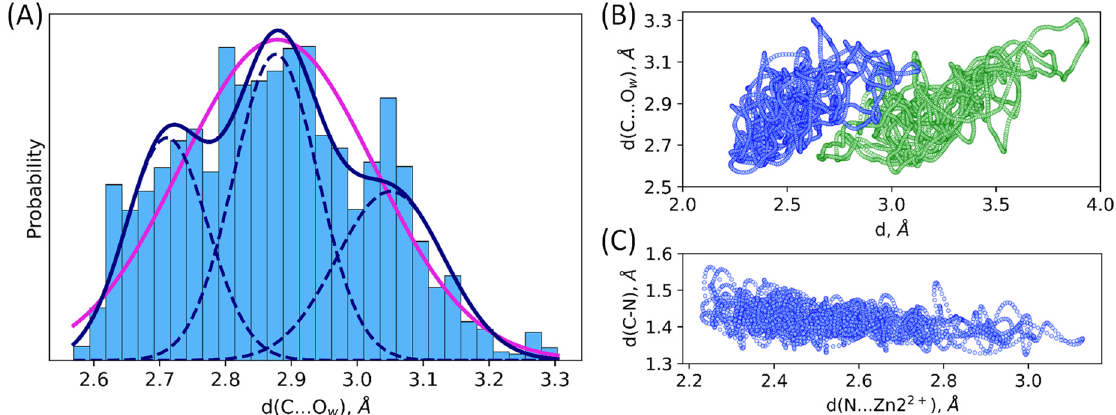
Figure 4. ( A ) One-state and three-state models of distribution of the nucleophilic attack distance, C…O w , in the NDM-1-ES. Magenta line corresponds to the unimodal normal distribution, and navy solid line is a sum of three normal distributions (navy dashed lines) with the corresponding weights. Scatter plots of interatomic distances in the MD trajectory of the NDM-1-ES; ( B ) distance of the nucleophilic attack, d(C…O w ) vs Zn1 2+ ...O (green) or Zn2 2+ ...N (blue) coordination bond, d; ( С ) C–N bond vs Zn2 2+ ...N bond.